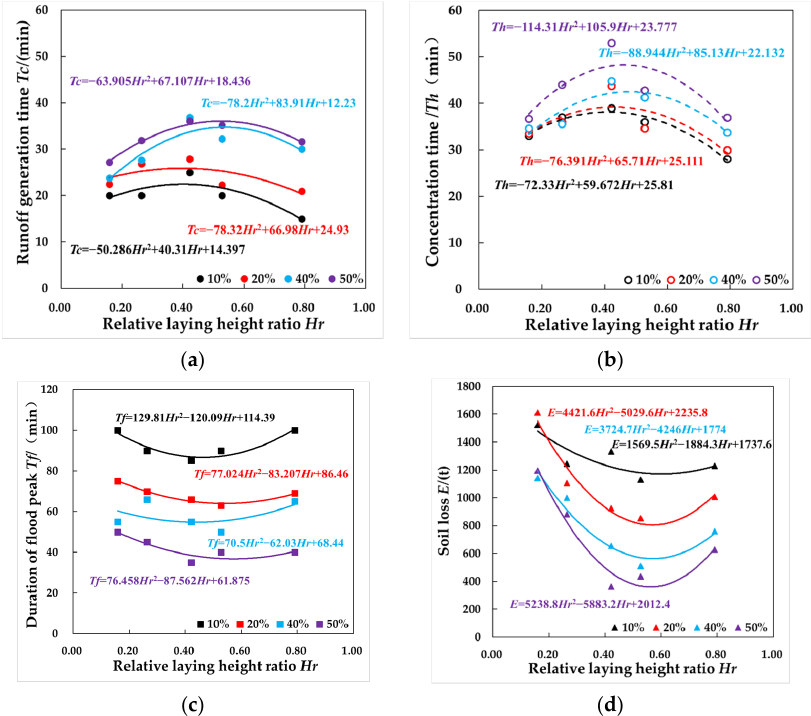
Figure 7. Variation law of watershed-erosion-transportation processes under the conditions of different terrace-laying areas and relative height. (( a ) Hr - T c , ( b ) Hr - T h , ( c ) Hr - T f , ( d ) Hr - E ).